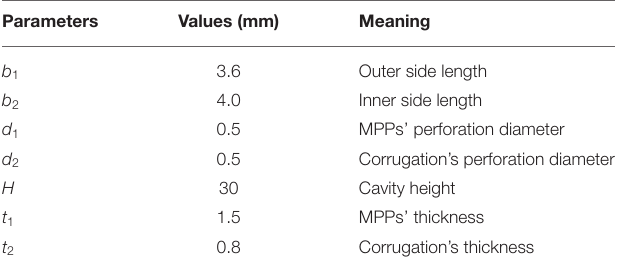
TABLE 1 | Geometric parameters of the